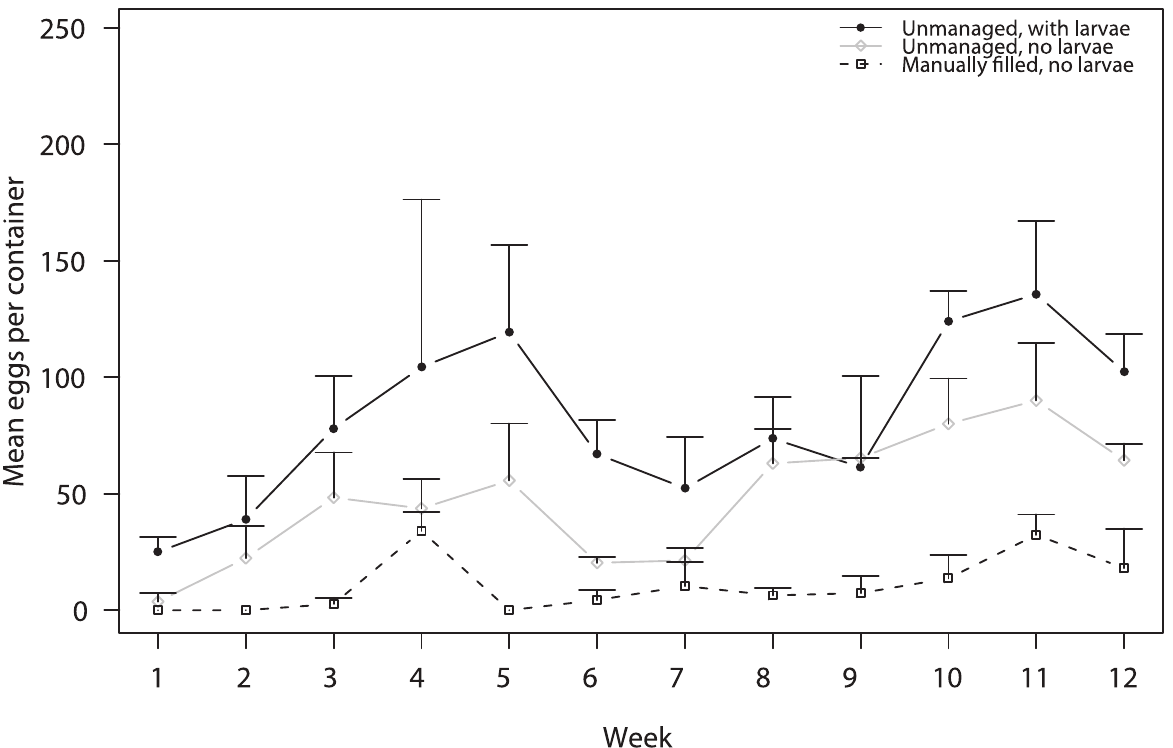
Figure 4. Mean number of eggs ( ± SE) laid per week by experimental container treatment.